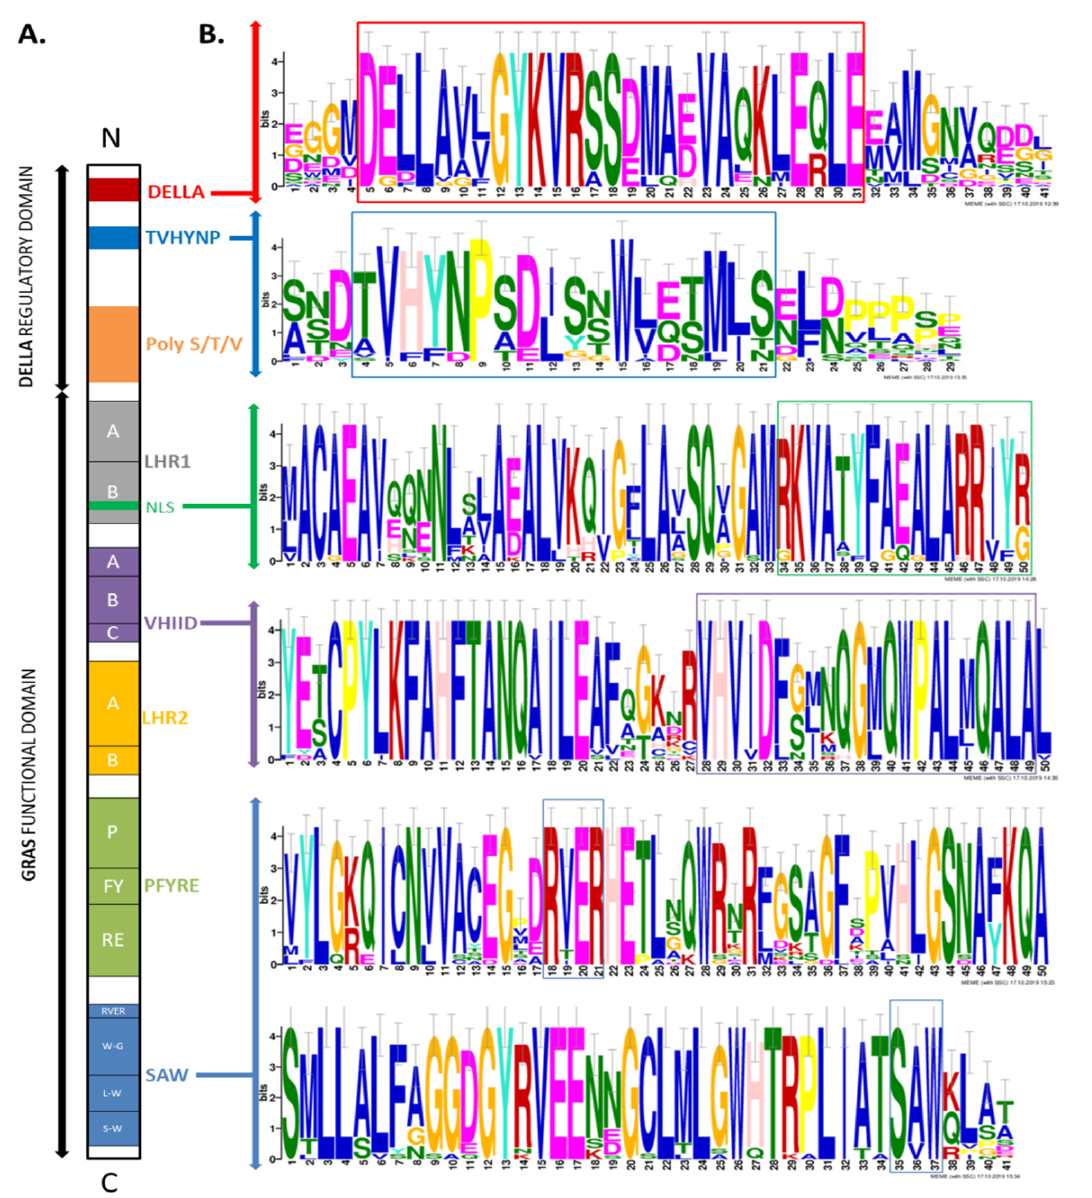
Figure 3. ( A ) Domain structure of a typical DELLA protein; ( B ) The motifs identified in the 23 DELLAs in different plant species. The overall height of each stack indicates the sequence conservation at that position, whereas the height of symbols within each stack reflects the relative frequency of the corresponding amino acid (MEME motif search tool).